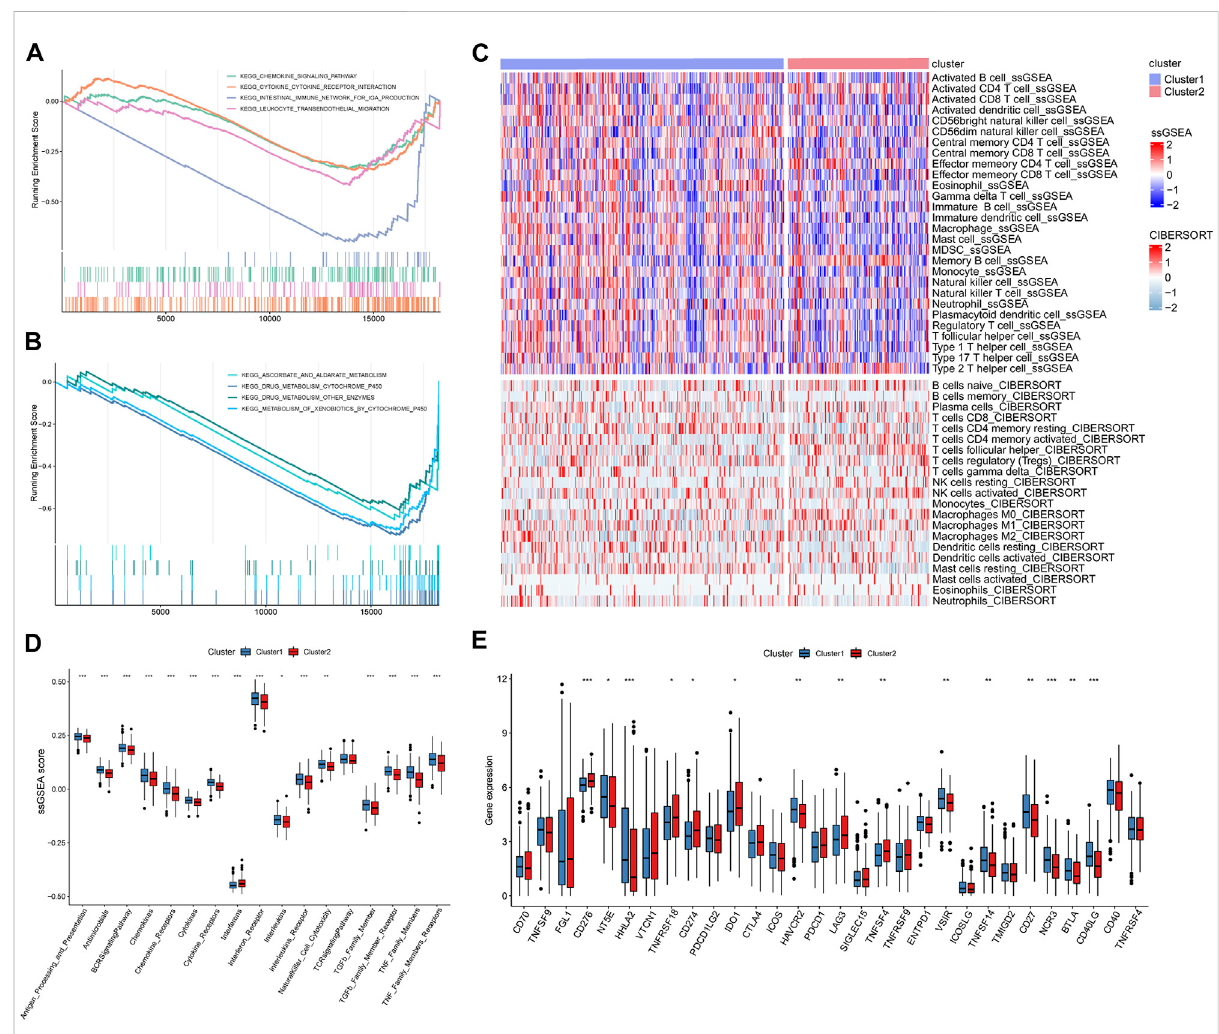
FIGURE 4 GSEA and immune landscape of distinct m5c/m6a modi fi cation subtypes. (A,B) GSEA of pathways related to different subtypes based on the C2 gene set. (C) Immune cell landscape of two m5c/m6a subtypes. (D) Boxplots comparing the ssGSEA scores of different molecular subtypes.